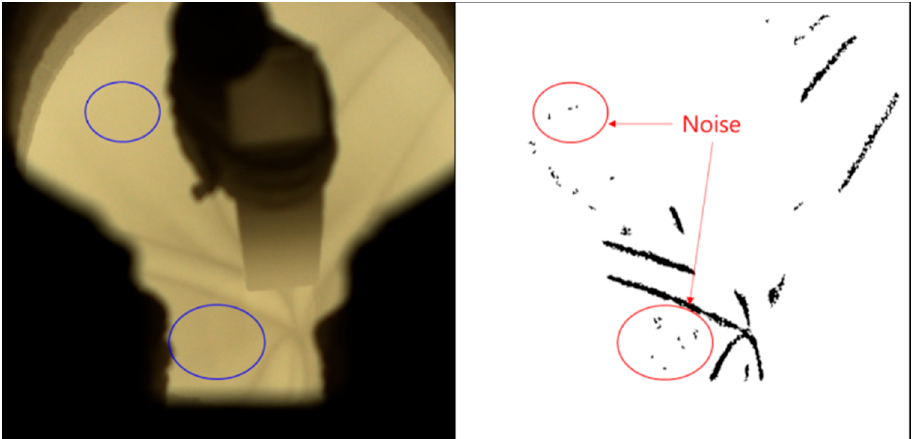
Figure 11. Noise elements after image preprocessing.